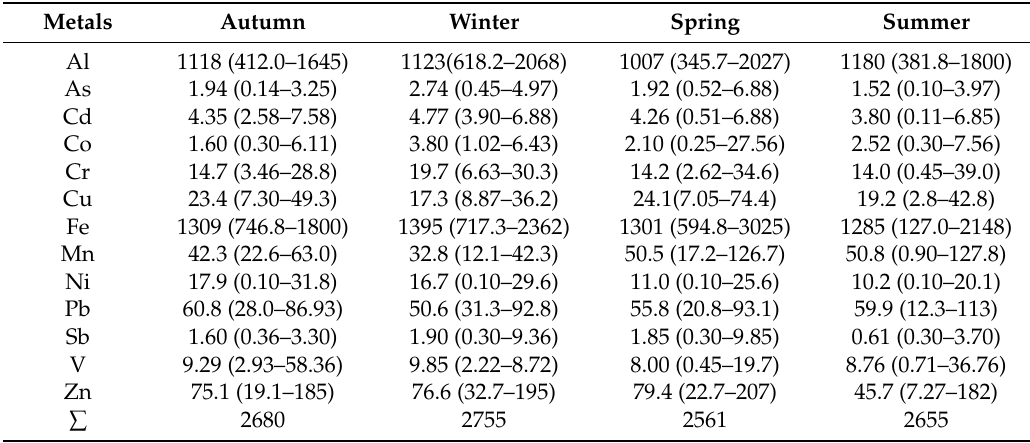
Table 5. Mean metals concentrations (ng m − 3 ) in PM 10 during autumn, winter, spring and summer. Min and Max values are reported in